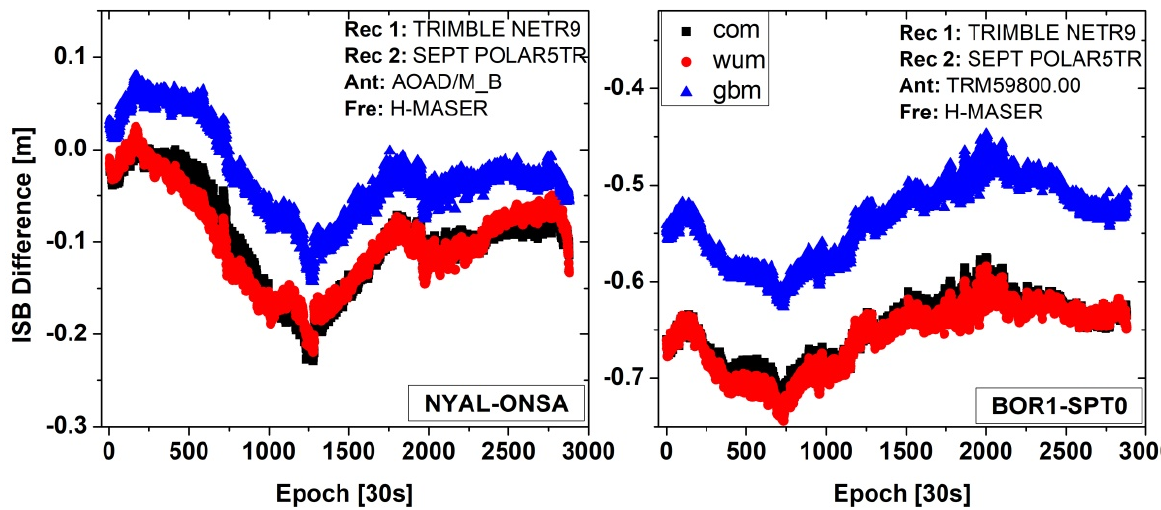
Figure 5. ISB difference series for scheme 2 on DOY 106, 2021.